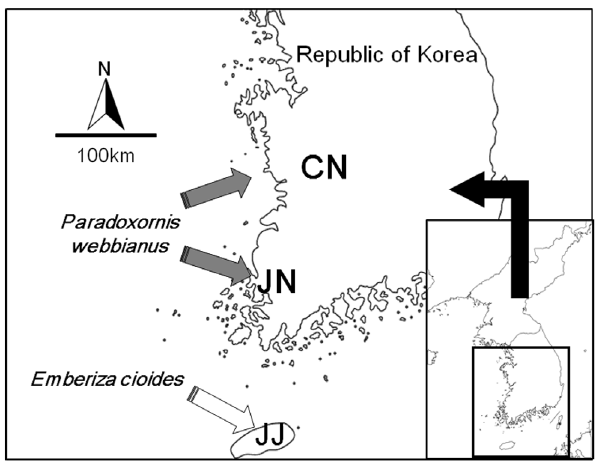
Figure 1. Location of study sites and the main hosts of the common cuckoos Cuculuscanorus . Two sites are located along the mainland of Korea (Chungcheongnam-do (CN; 36 u 27 9 N, 127 u 07 9 E), Jeollanam-do (JN; 34 u 48 9 N, 126 u 22 9 E)) and one site is on an island, Jeju- do (JJ; 33 u 31 9 N, 126 u 32 9 E). The vinous-throated parrotbill Paradoxornis webbianus is known to be the main host species in the mainland of Korea while this species does not inhabit JJ at all. The meadow bunting Emberiza cioides is known to be a potential primary host on JJ.